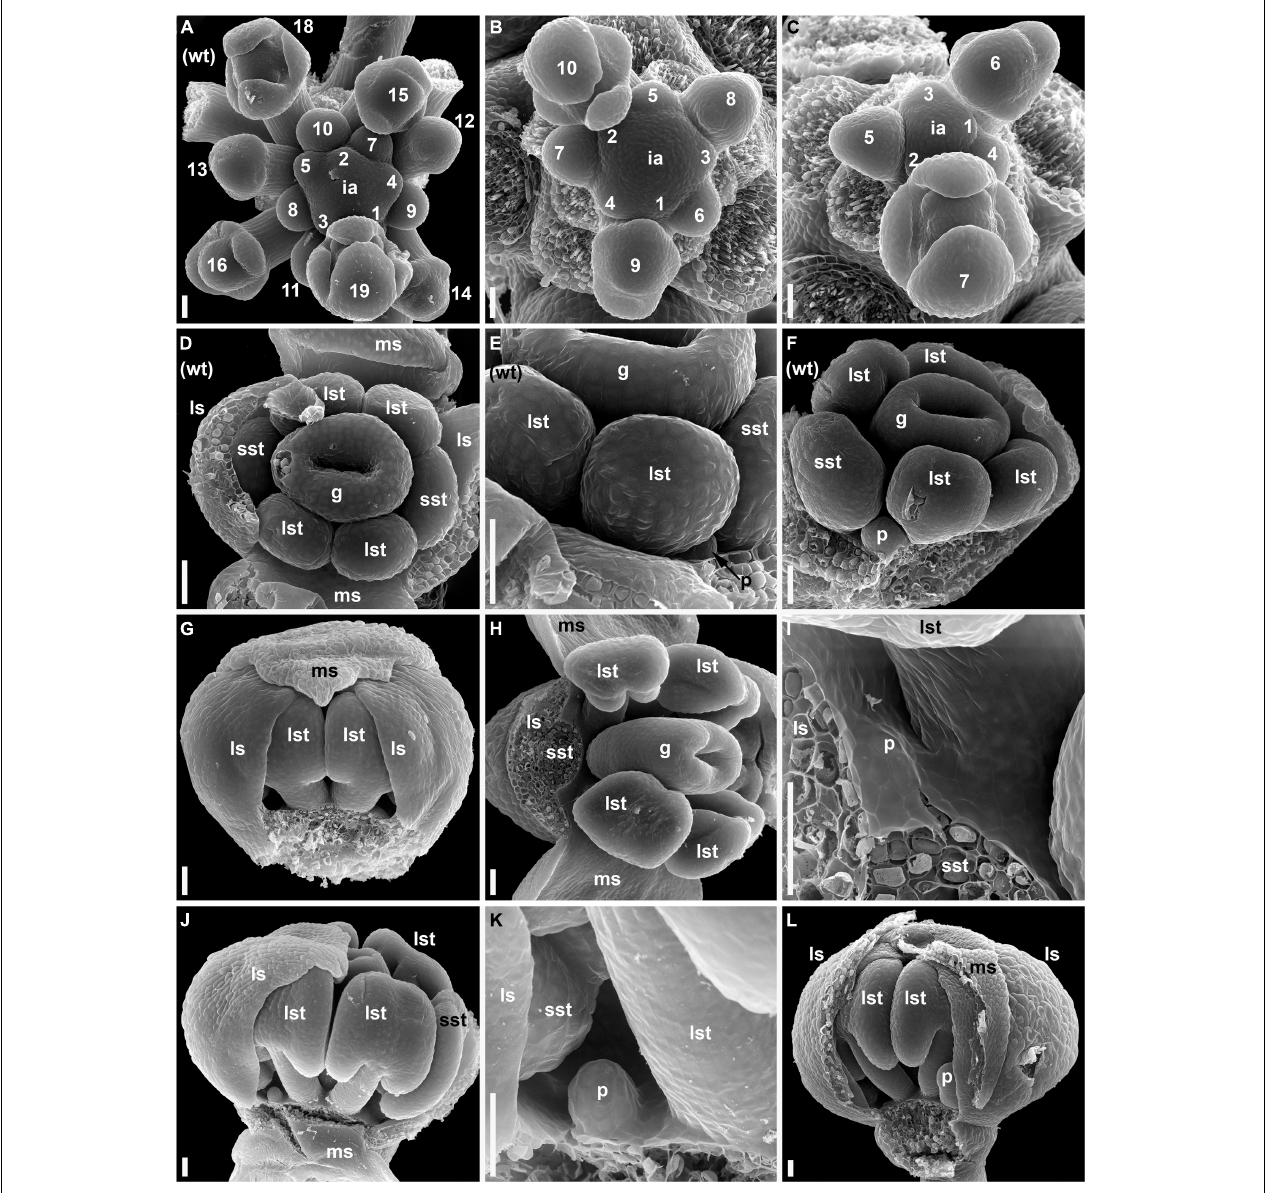
FIGURE 2 | Flower development in the wild-type (A,D–F) and lel plants (B,C,G–L) of C. bursa - pastoris (SEM). (A–C) Inflorescence apices with flowers at the sequential stages of early development. The flowers are numbered sequentially from the youngest to the oldest. (D–F) The earliest stages of petal development in the wild type. (D,E) A flower with lateral sepals removed. (D) Top view. (E) Detail of side view. It is noted that the very small petal and the virtual absence of stamen filaments. (F) A flower with sepals removed. The petal is larger than in (E) , and very short stamen filaments are present. (G–L) Early petal development in lel plants. (G) Side view of a flower with one median sepal removed. It is noted that the gaps on either side of the visible pair of long stamens. A small petal primordium is present in the right-hand gap. (H) A flower with a sepal and a stamen removed. (I) Detail of (H) showing a petal primordium. (J) Side view of a flower with three of four sepals removed. A young petal is present left to the removed median sepal. There is no petal right to the median sepal (although there is enough space for its initiation). (K) Detail of (J) showing the petal. (L) Side view of flower with a median sepal partially removed. There is a petal right to the median sepal, but no petal left to it. g, gynoecium; ia, inflorescence apex; ls, lateral sepal; lst, long stamens; ms, median sepal; p, petal; sst, short stamens; wt, wild type. Scale bars: 30 µ